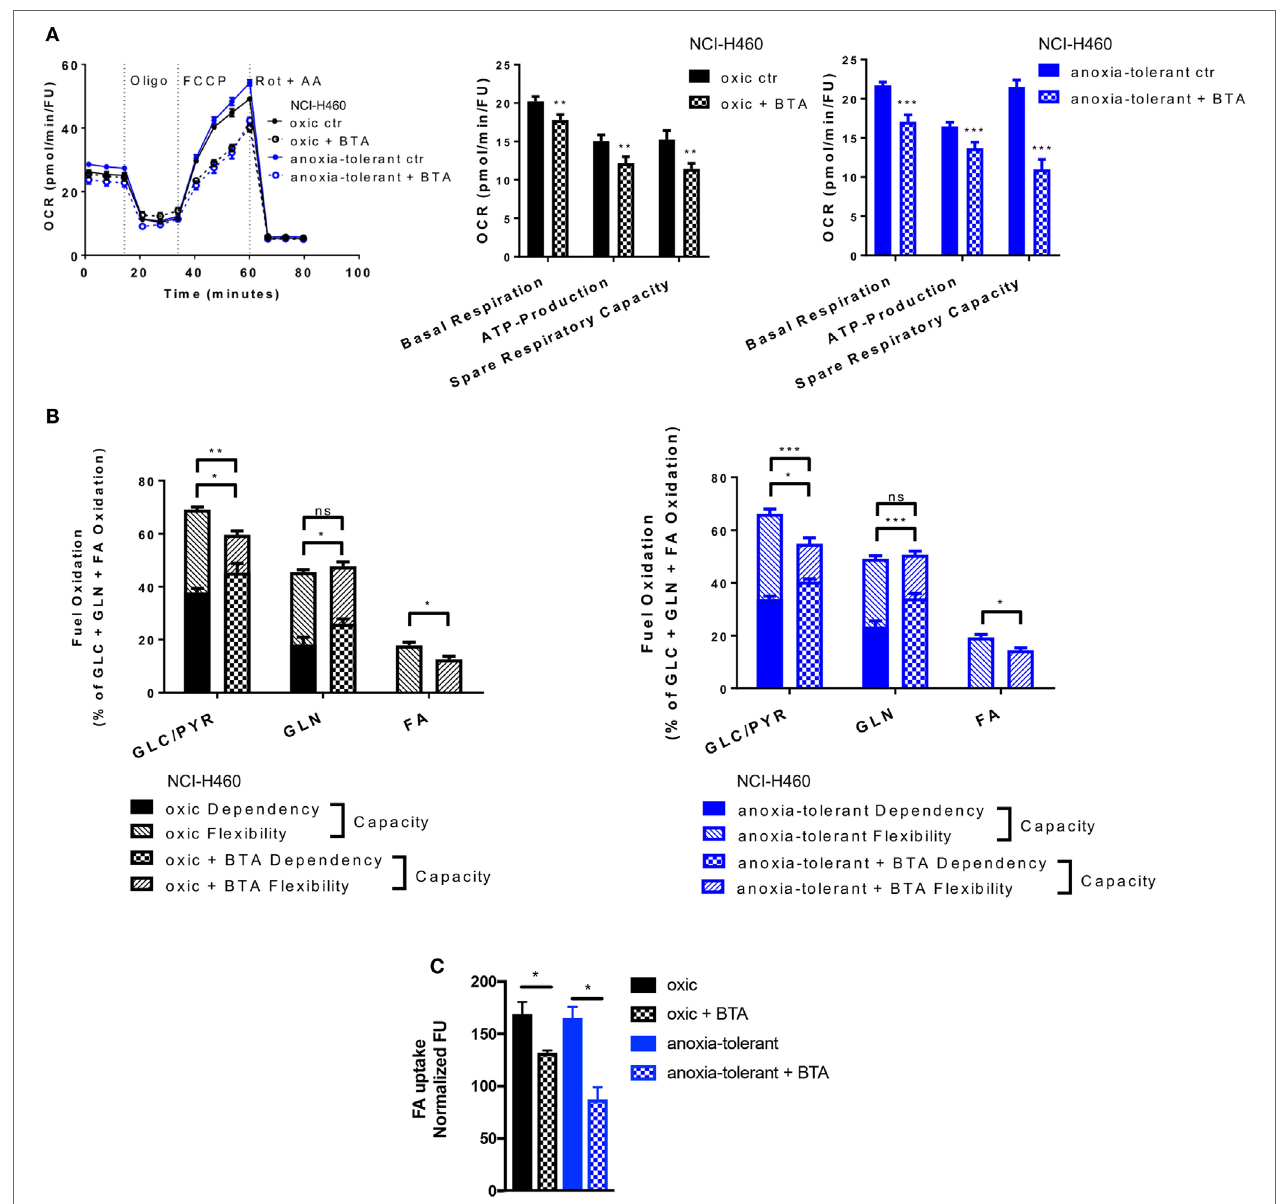
FigUre 5 | Metabolic alterations upon SLC25A1 Inhibition in NCI-H460 oxic and anoxia-tolerant cells. NCI-H460 oxic and anoxia-tolerant cells were treated for 24 h with 5 mM 1,2,3-benzene-tricarboxylic acid (BTA) under standard ambient conditions and various parameters of cell metabolism were determined by using a Seahorse XFe 96 analyzer. Fatty-acid (FA) uptake was measured by using the fluorescent FA analog C1-BODIPY ® 500/510 C12. (a) Oxygen consumption rate (OCR) was measured using Mito Stress Test Kit and normalized to Hoechst 33342 fluorescence units (FU) 24 h after treatment with BTA. Real-time Injection of oligomycin (Oligo, 1 µM), carbonyl cyanide- 4 -(trifluoromethoxy)phenylhydrazone (FCCP, 2 µM), Rotenone (Rot, 0.5 µM) and antimycin A (AA, 0.5 µM). Calculated parameters of the assay are indicated in bar graphs. (B) Percentage of total mitochondrial respiration for each fuel pathway measured with Seahorse XFe 96 analyzer using Fuel Flex Test Kit 24 h after treatment with BTA (fuel pathways: GLC/PYR: Glucose/Pyruvate, inhibition by UK5099; GLN, glutamine, inhibition by BPTES, FA: fatty acids, inhibition by etomoxir). (c) FA uptake measured after 24 h of BTA treatment. Mean values ± SEM are shown. Data in (a) and (B) from n = 12–18 wells from two independent experiments; Data in (c) n = 3 (* p ≤ 0.05, ** p < 0.01, and *** p ≤ 0.001. (a) t-test; (B) and (c) two-way ANOVA with Tukey